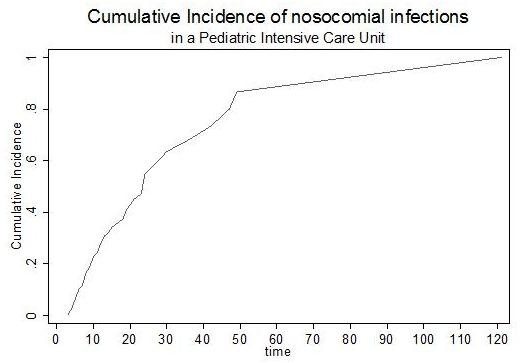
Cumulative incidence of nosocomial infections in the Pediatric Intensive Care Unit. Graphic shows the cumulative incidence (in days) of nosocomial infections.